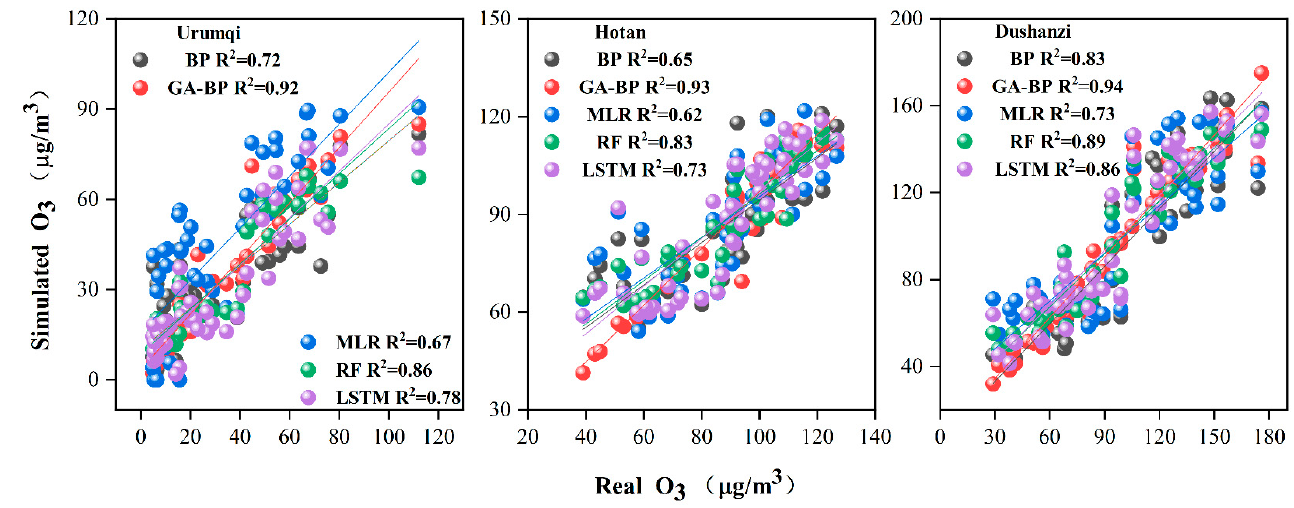
Figure 5. Determination coefficients (R 2 ) of simulated O 3 and real O 3 by the GA-BP artificial neural network with four other methods (BP, MLR, RF, and LSTM) in Urumqi, Hotan, and Dushanzi dis- tricts.